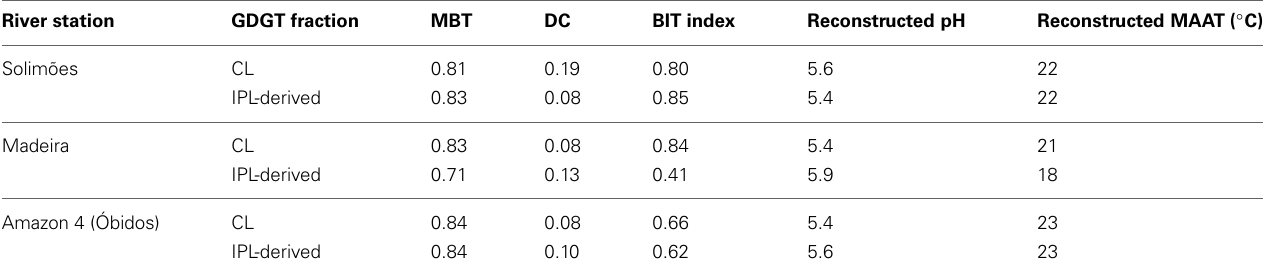
Table 4 | Flux-weighed MBT, DC, BIT, and reconstructed pH and MAAT at Solimões, Madeira, and Amazon 4 (Óbidos) stations. River station